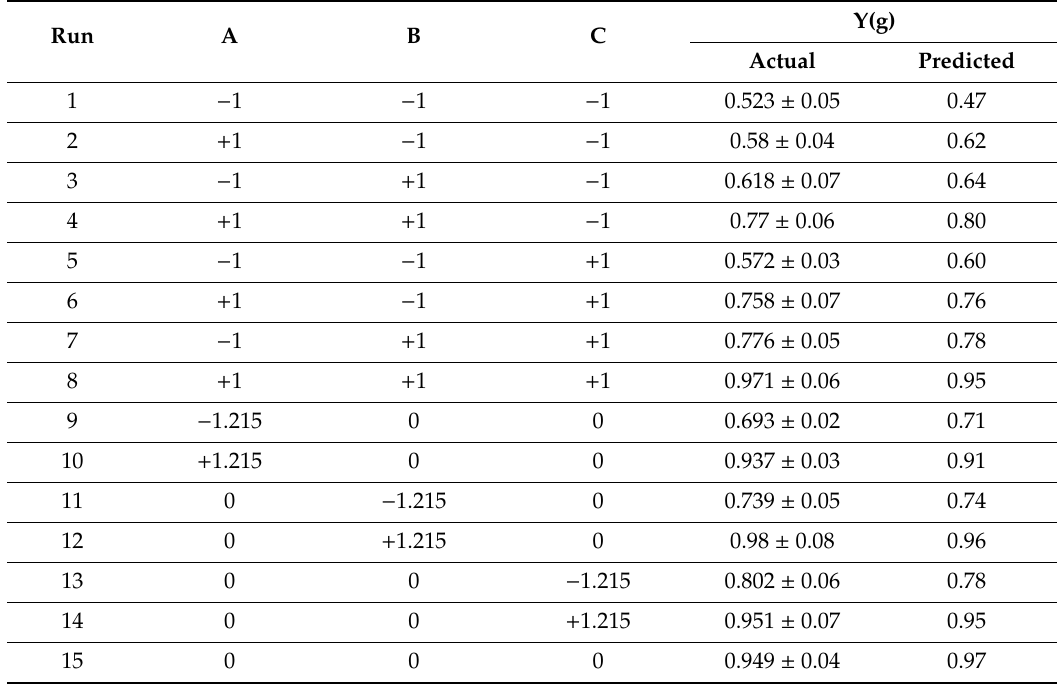
Table 2. Empirical data with corresponding actual and predicted response